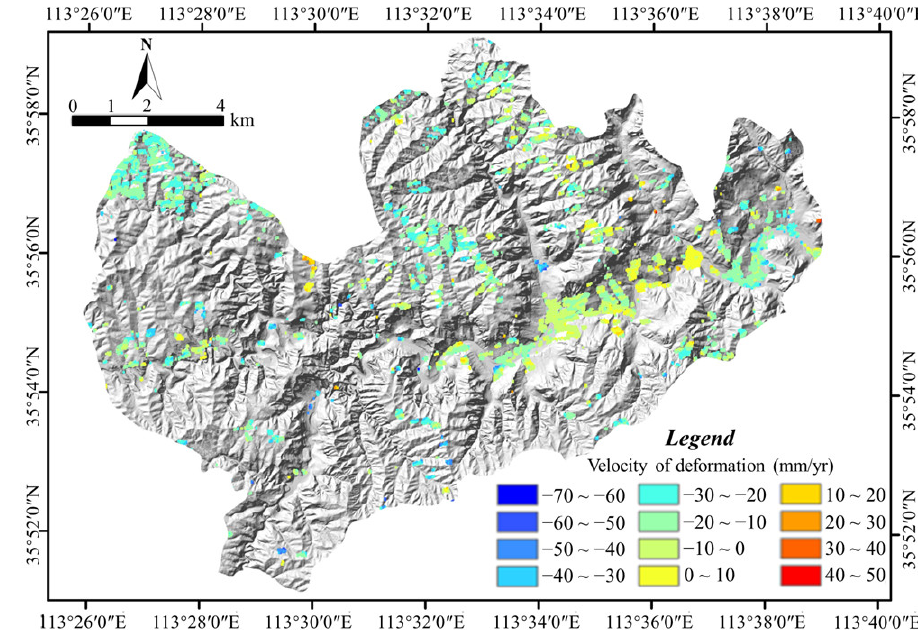
Figure 16. Calculation results of SBAS-InSAR in the Taihang GCSA.